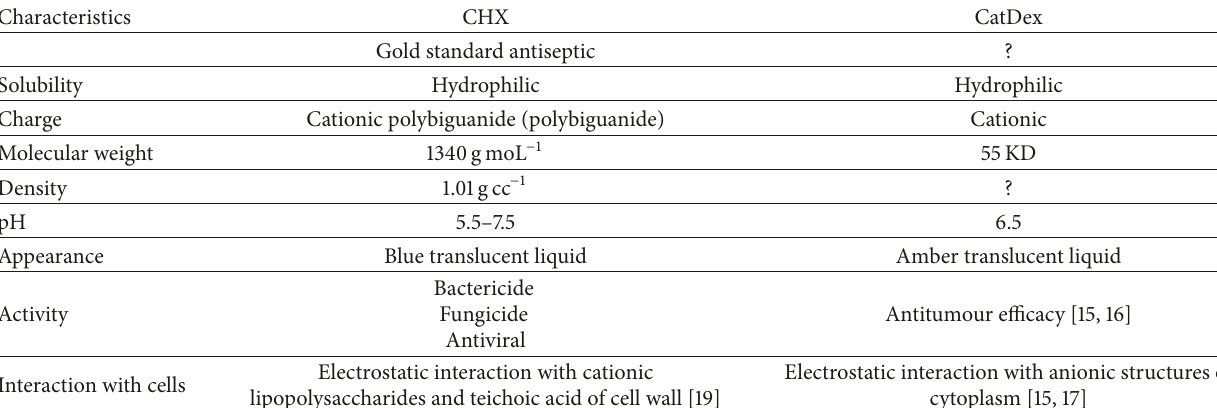
Table 1: Comparative table of the physicochemical and biological properties of CatDex and CHX.